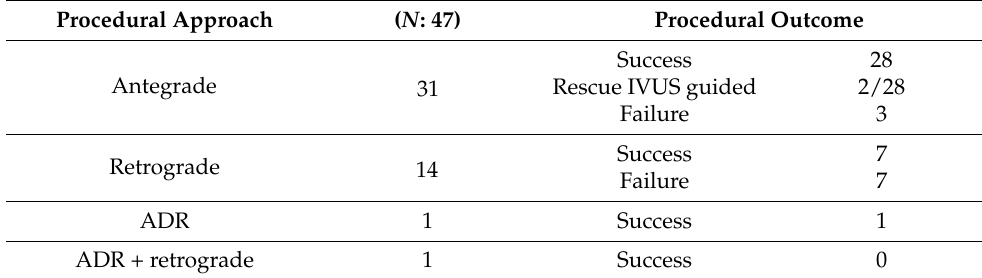
Table 4. Procedural approach and outcome of reattempted CTO-PCI.